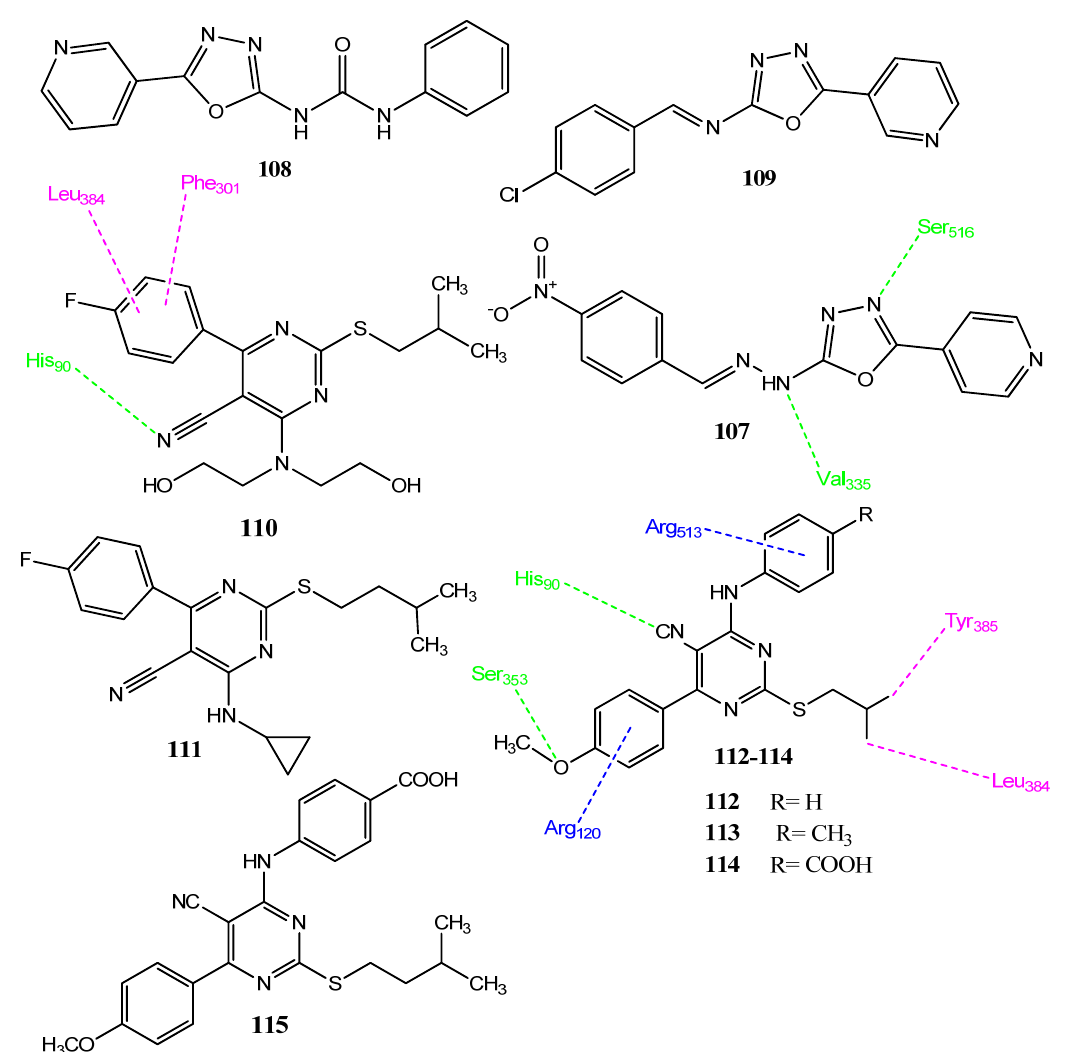
Figure 22. Oxadiazole and pyrimidine derivatives.